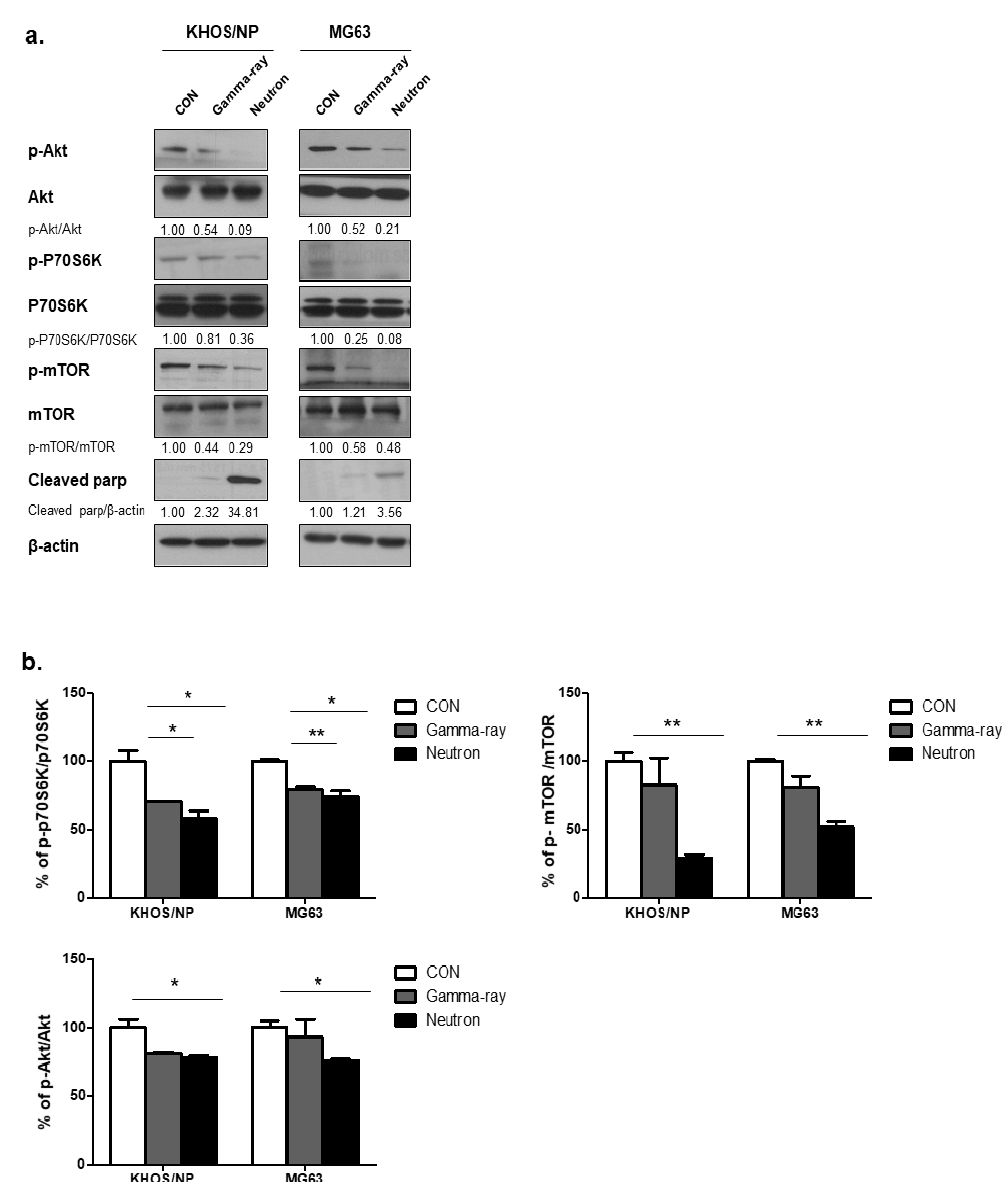
Figure 3. Akt-mTOR signaling pathway activation by gamma-rays or neutrons. ( a ) Immunoblot analysis of p-AKT, p-70S6K, p-mTOR, and cleaved PARP in KHOS / NP and MG63 cells treated with radiation for 48 h. ( b ) ELISA was performed to quantify the levels of phospho-mTOR, mTOR, phospho-AKT, and AKT in KHOS / NP and MG63 cells after irradiation. Each concentration was tested in quadruplicate, and each experiment was repeated twice. The data shown represent the mean ± SD from two independent experiments combined; * p < 0.05, ** p < 0.01.